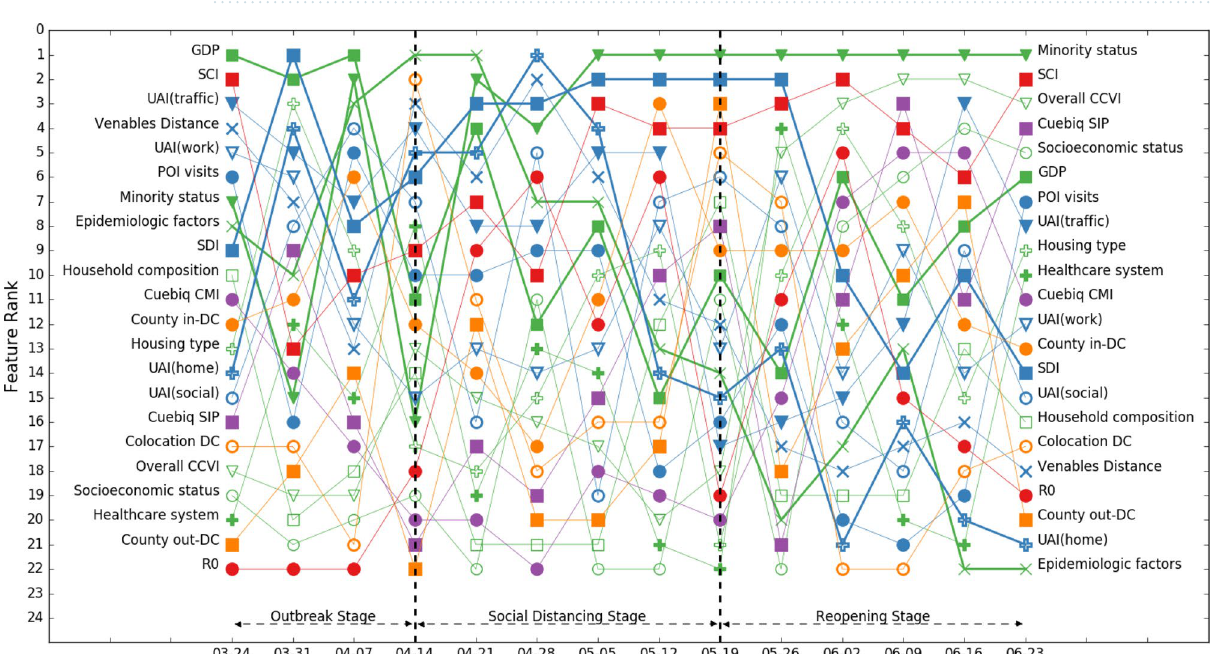
Figure 6. Rank of feature importance of model 4 throughout three stages of COVID-19. Social distance index shows high importance in counties with low population densities.